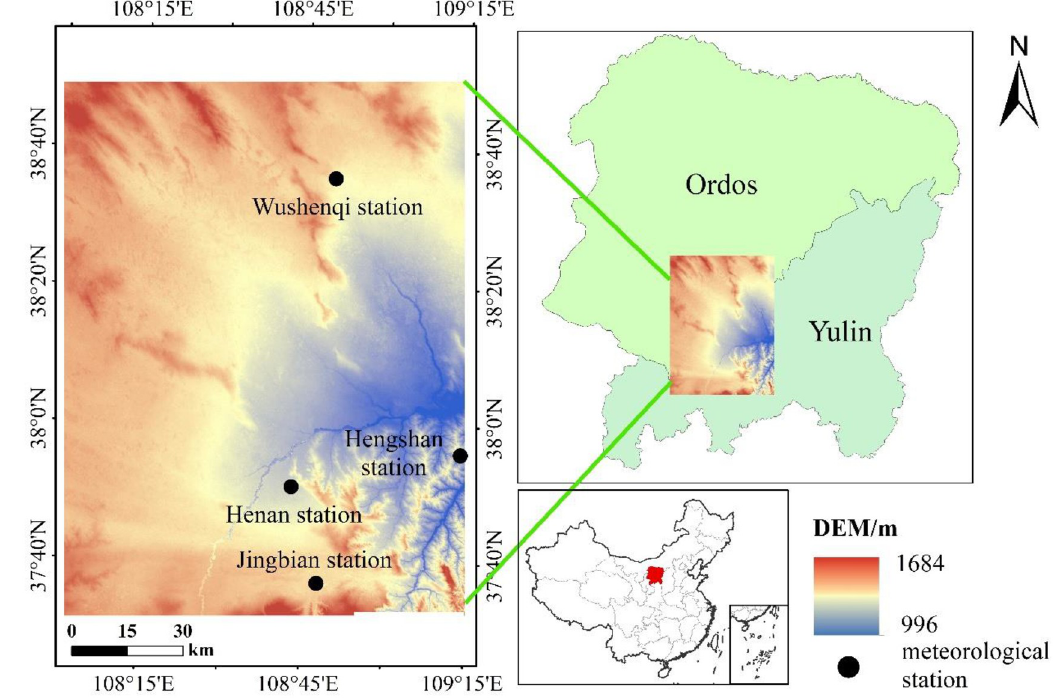
Fig 1. Location of the study area in agro-pastoral ecotone of northwest China.